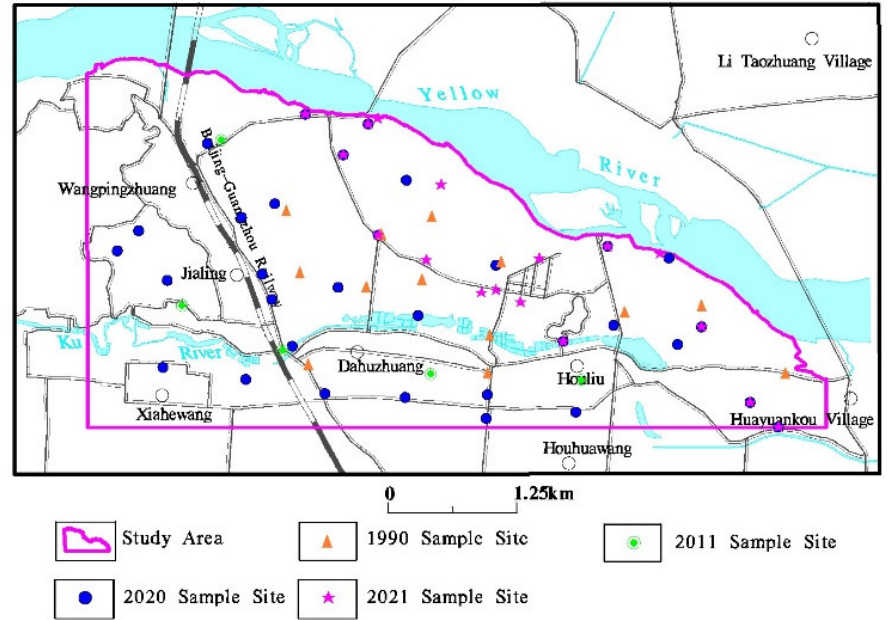
Figure 3. Distribution map of sampling points in the study area.